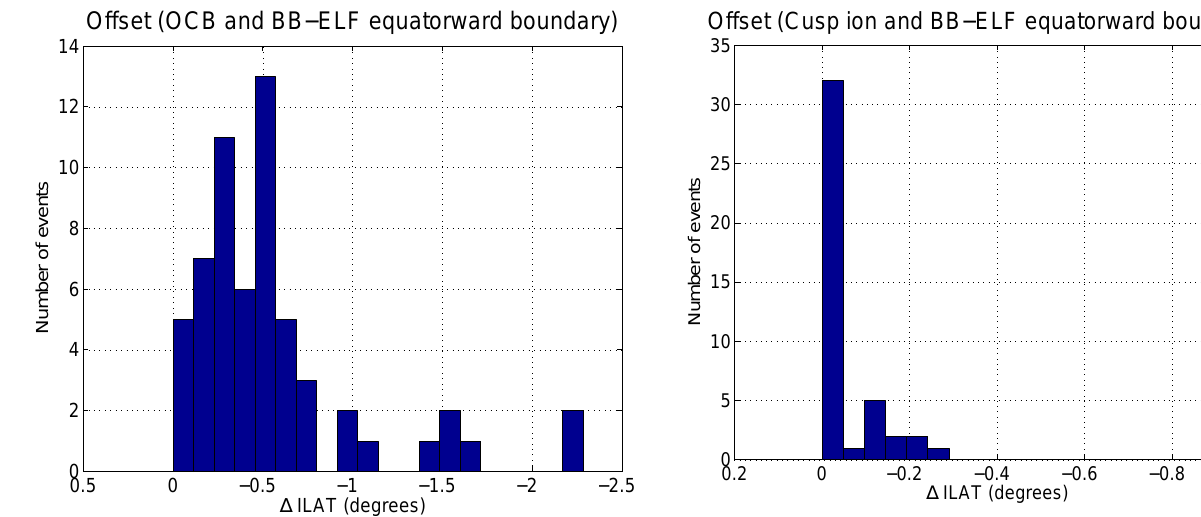
Fig. 4. Histogram of the latitudinal distance between the OCB and the onset of the BB-ELF activity. A negative value means the BB- ELF starts poleward of the OCB.